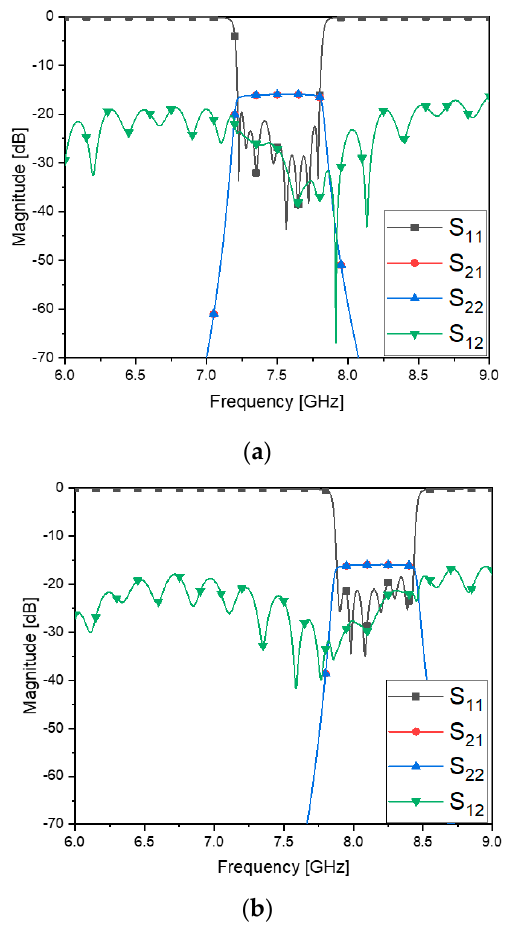
Figure 12. RF − link and channel selectivity test which assumes a frequency change in the bandpass filter block. ( a ) S-parameters of filter − combined antenna with the frequency of the BPF before the change. ( b ) S − parameters of filter − combined antenna with the frequency of the BPF after the change. Table 9. Comparing the characteristics of the proposed filter and others’ filters with antennas.